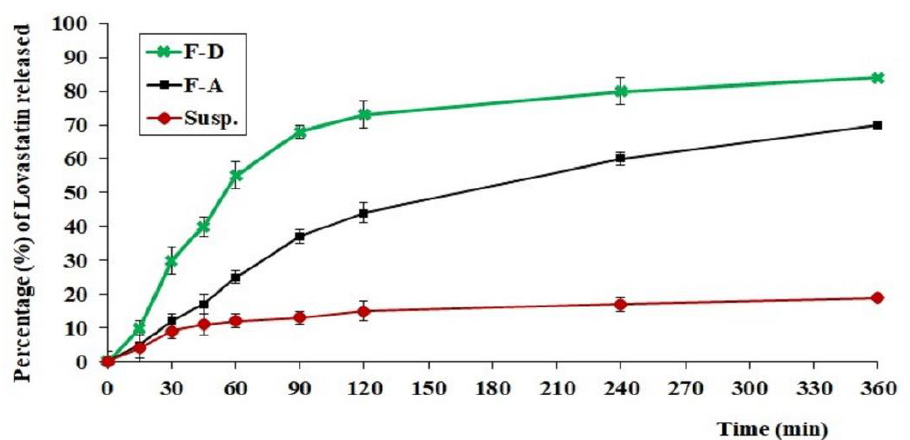
Figure 9. In vitro release profiles of LV from different formulations.